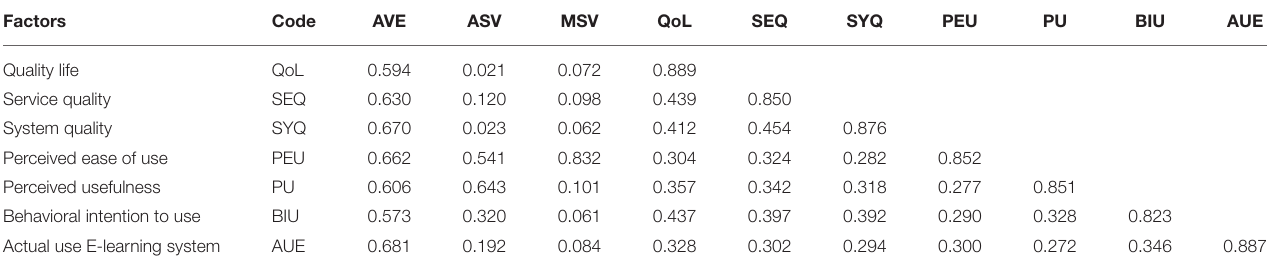
TABLE 4 | Discriminant validity.